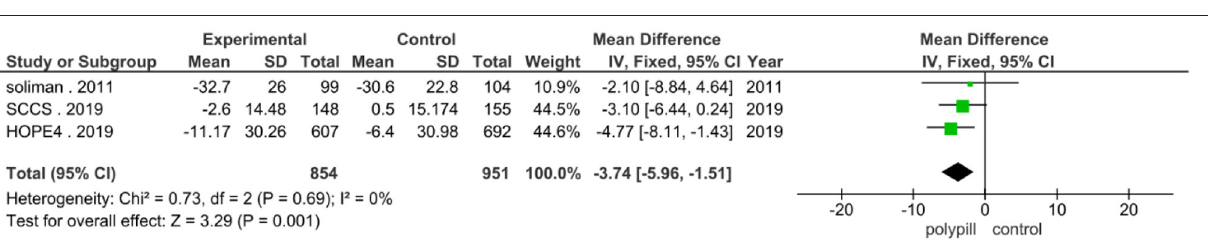
FIGURE 6 | Forest plot of the difference in the 10-year predicted cardiovascular risk.